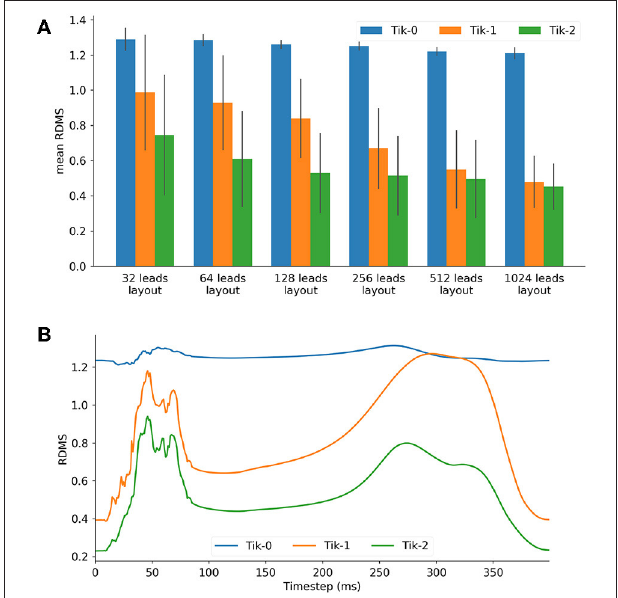
FIGURE 3 | (A) Mean RDMS against lead layout, (B) 128 lead layout RDMS vs. timestep for the 3 Tikhonov